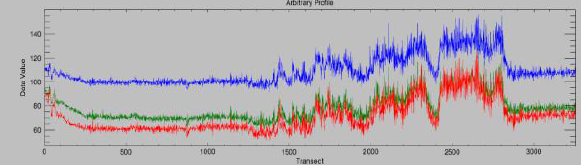
Figure 4b. Amplitudes of the red-green-blue channels along transect A-A’ from figure 4a.